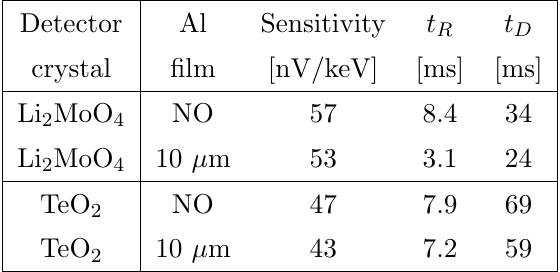
Table 2 . Sensitivities and pulse-shape parameters of detectors without and with 10 (cid:22) m thick Al (cid:12)lm. The crystal size is 20 (cid:2) 20 (cid:2) 10 mm and the measurement is performed with the detector-holder temperature stabilized at 22